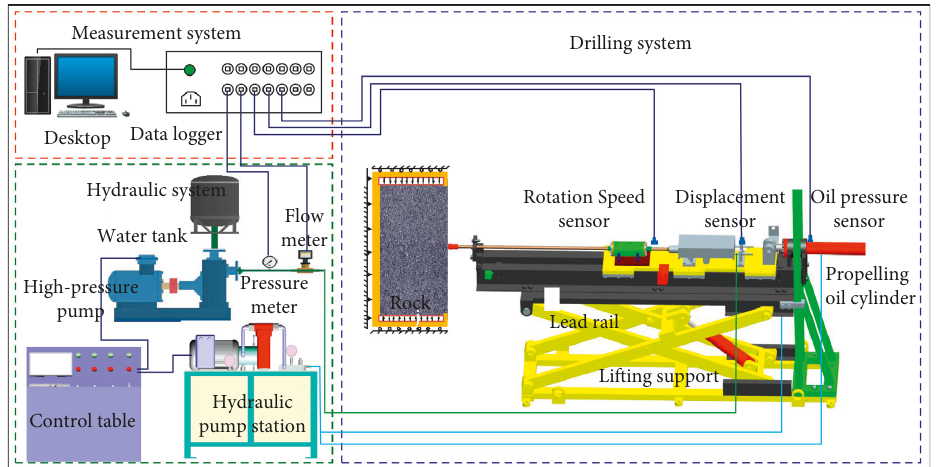
Figure 9: Experimental platform for rock